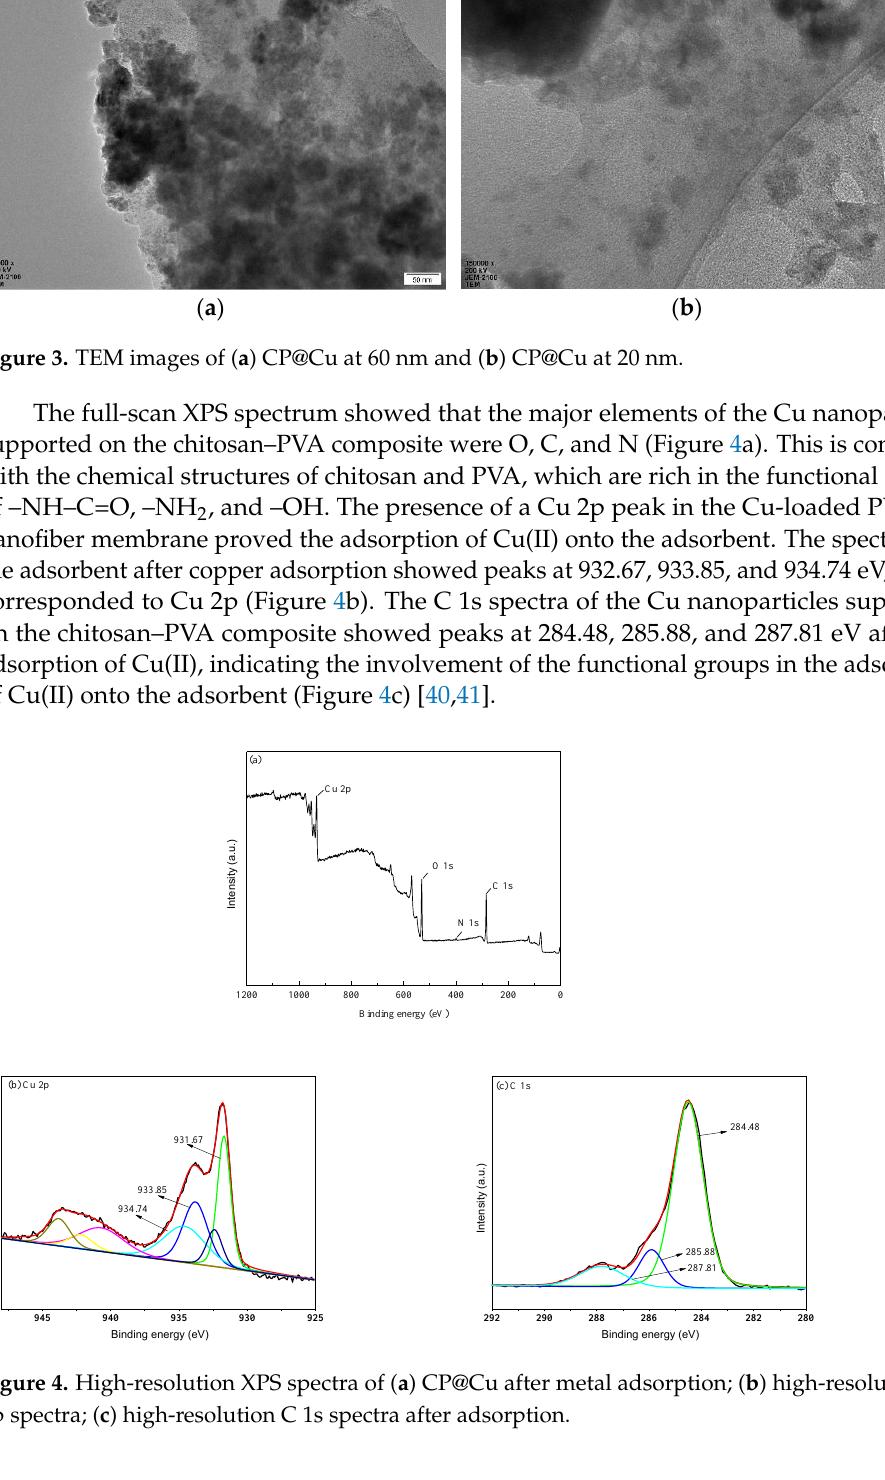
Figure 2. The recycling experiments.